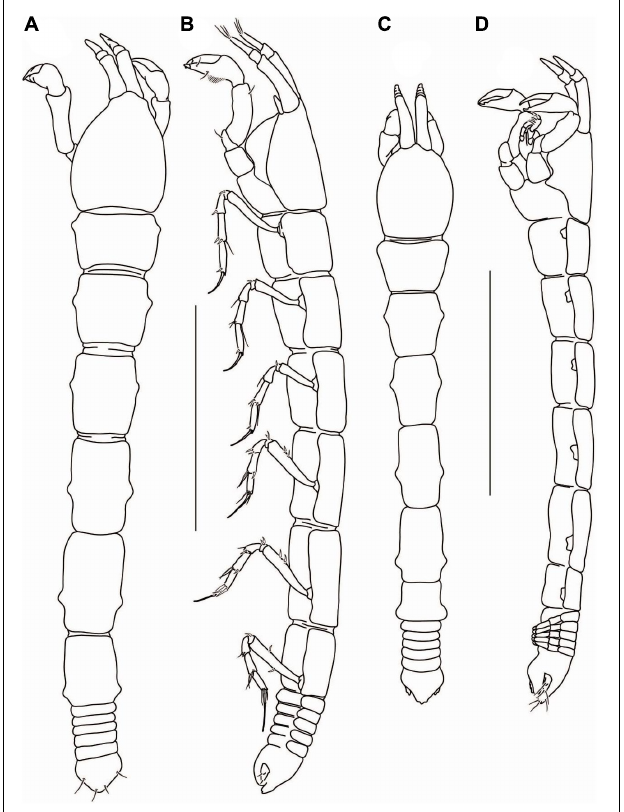
FIGURE 11 | Agathotanais oharai n. sp., neuter, holotype ( A,B : NMV J 74742), juvenile male, paratype ( C,D : NMV J 74725). (A) dorsal view; (B) lateral view; (C) dorsal view; (D) lateral view. Scale bar: (A–D) = 1 mm.